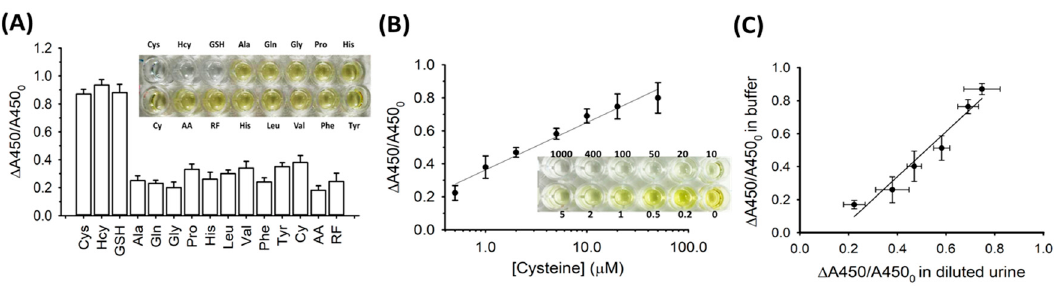
s1. Figure S1: Di ff erence in the fluorescence intensity of FITC-AuNPs before and after the addition of I − . Figure S2: Responses of AuNPs to di ff erent